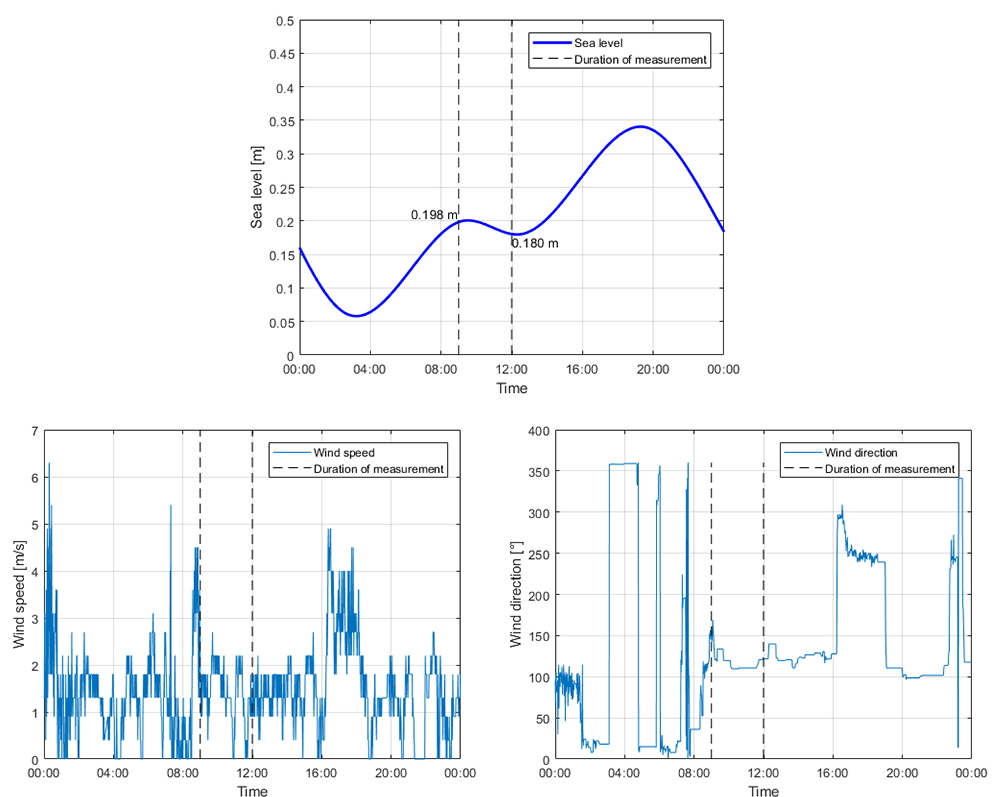
Figure 2. Field measurements conditions: sea level ( top ); wind speed ( bottom left ); and direction ( bottom right